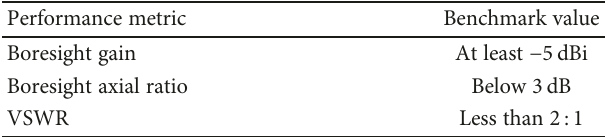
Table 2: Performance metrics for (2 – 18 GHz) spiral